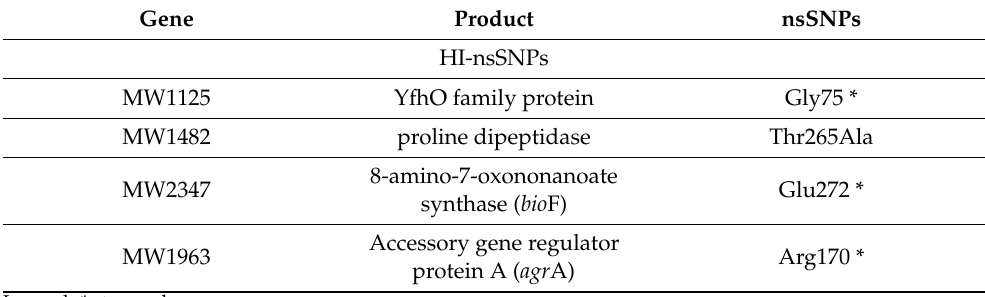
Table 4. HI nsSNPs in 1-R vs. 1-S on MW2 CA-MRSA RefGen mapping.